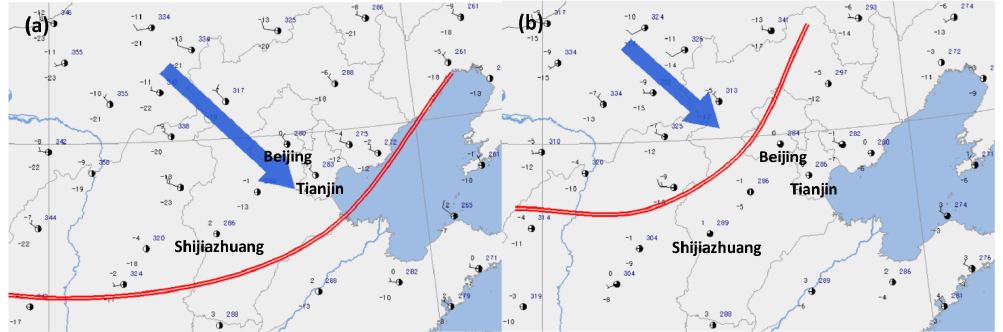
Figure 4. The weather analysis maps in December 2014 (a) and 2015 (b) . Red line represents WSCL.